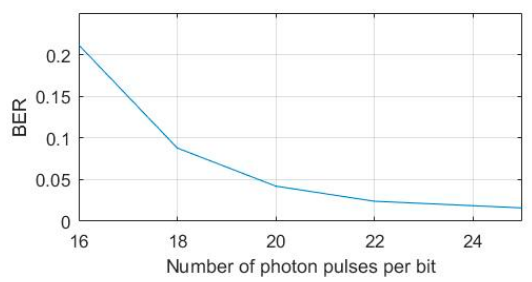
Figure 7. BER at different average number of photon pulses per bit.